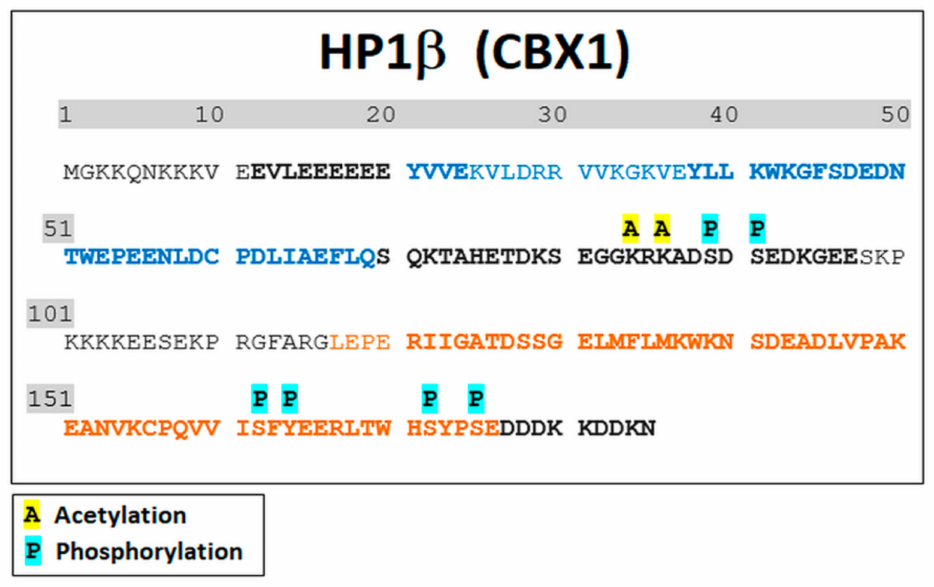
Figure 3. Characterization of HP1 β protein in human cervix adenocarcinoma (HeLa) cells using MS. Glu-C endoproteinase was used for protein digestion. After filtering the LC-MS / MS data in Proteome Discoverer 2.2 (see Methods for details), 75% sequence coverage was obtained (marked in bold type). Identified PTMs, including phosphorylation (P) and acetylation (A) are indicated. The amino acid sequence corresponding to CD and CSD domain is shown in blue or orange, respectively, with hinge region in